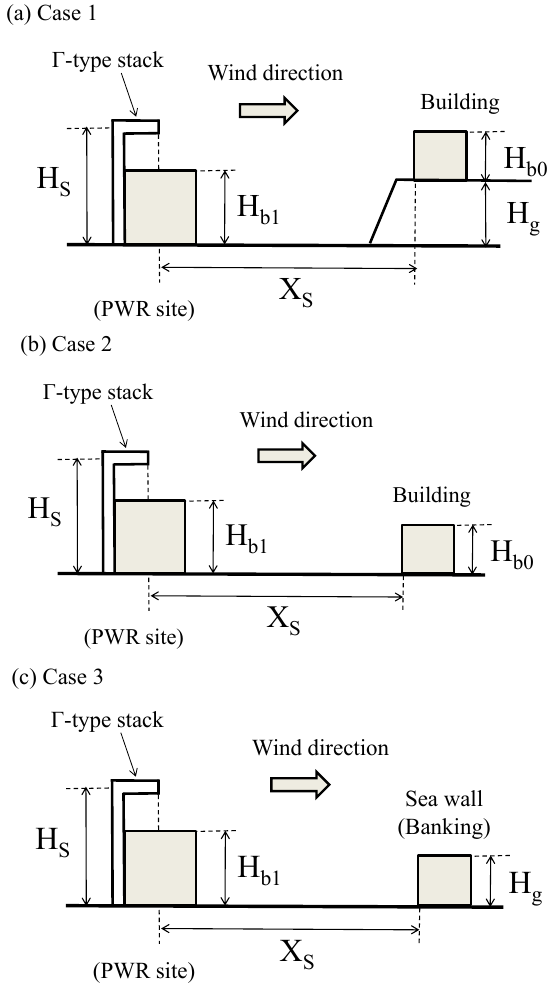
Figure 2. Layouts of the additional structures (building, sea wall and banking). ( a ) Case 1; ( b ) Case 2; ( c ) Case 3.